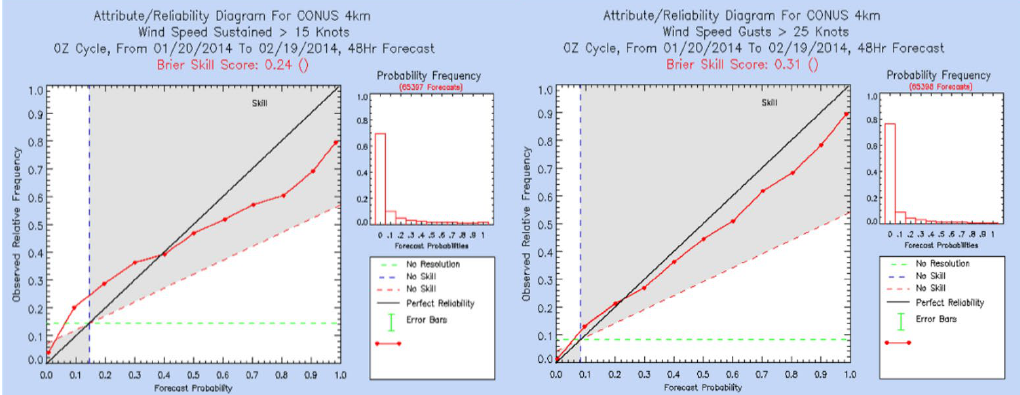
Figure 14. Reliability/Attribute diagram for the 4-km MEPS probability (percent) of 10-meter sustained winds ( left ) exceeding 15 knots (7.7 m/s) and 10-meter wind gusts ( right ) exceeding 25 knots (12.9 m/s) compared to 10-meter wind observations in the US from 20 Jan 2014 to 19 Feb 2014.